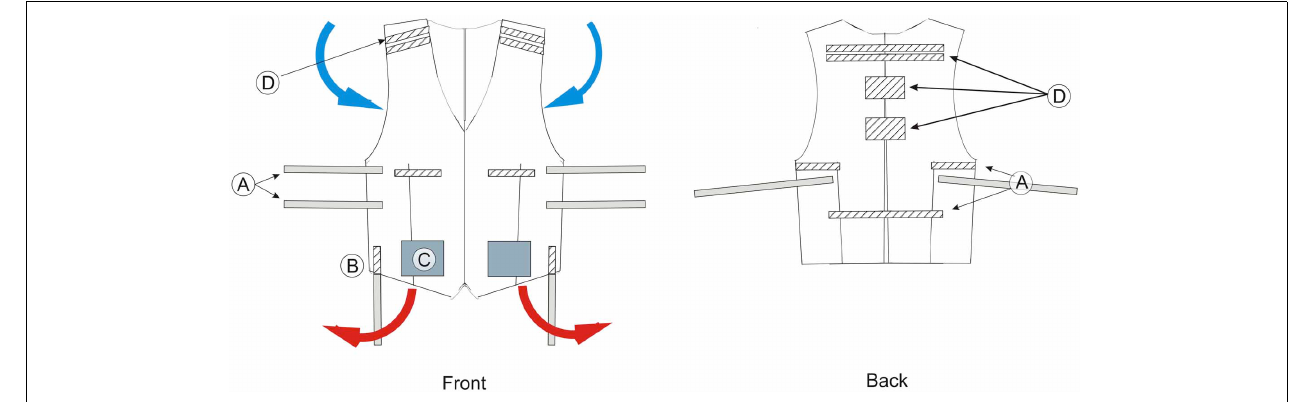
FIGURE 9 | Schematics of the modified cooling vest. Left: Front of the vest. Right: Back of the vest. A, Hook and loop strap bands for vest size adjustment and fitting; B, Strap bands for cable holding; C, Integrated cooling